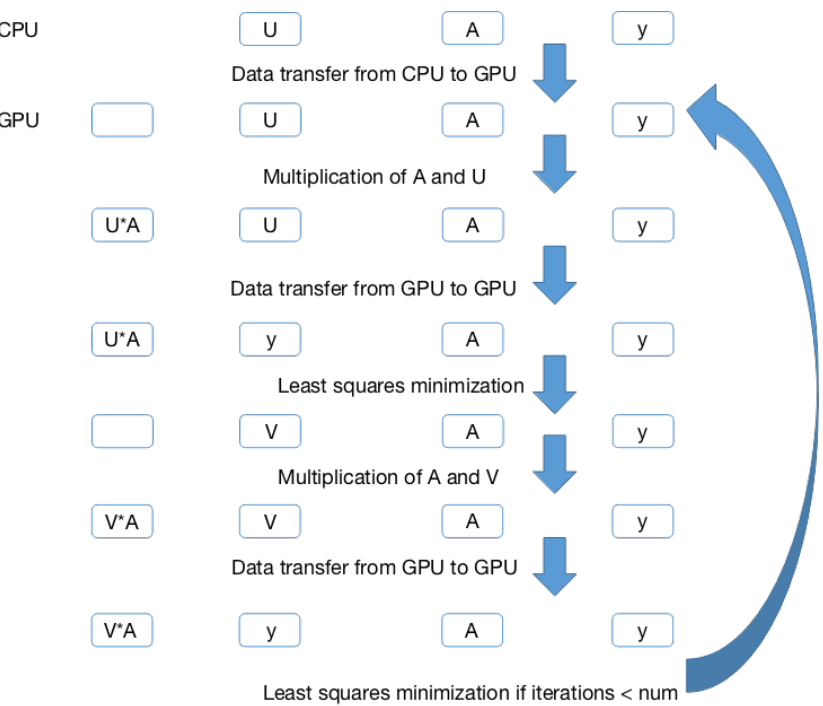
Figure 4. Memory organization in the calculation